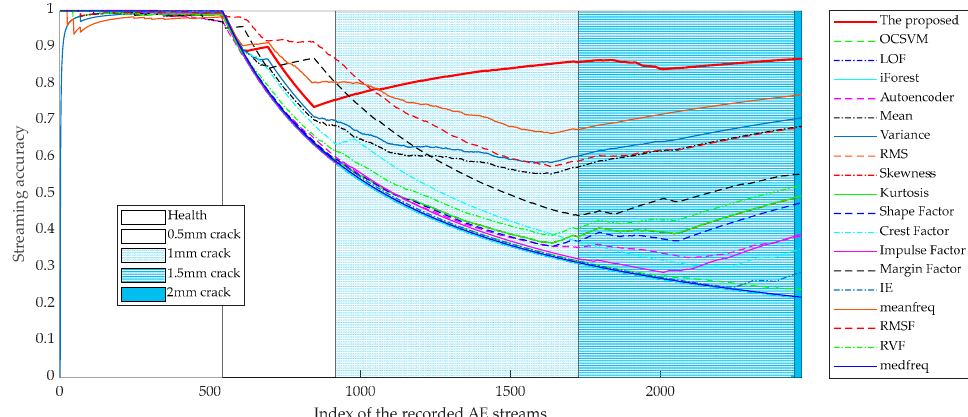
Figure 12. The streaming accuracy of the probed methods.